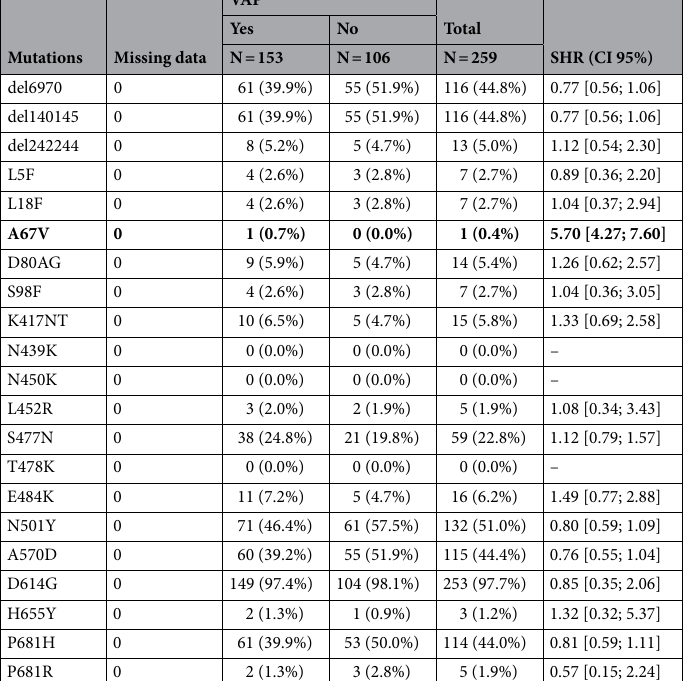
Table 2. Association between relevant mutations [(substitutions, deletions (Del)] in spike selected a priori and risk of ventilator-acquired pneumonia by univariable Fine and Gray model analysis. SHR sub-hazard ratio, CI 95% 95% confidence interval; variables are shown as median [quartile 1-quartile 3] and number (percentage). Significant values are in